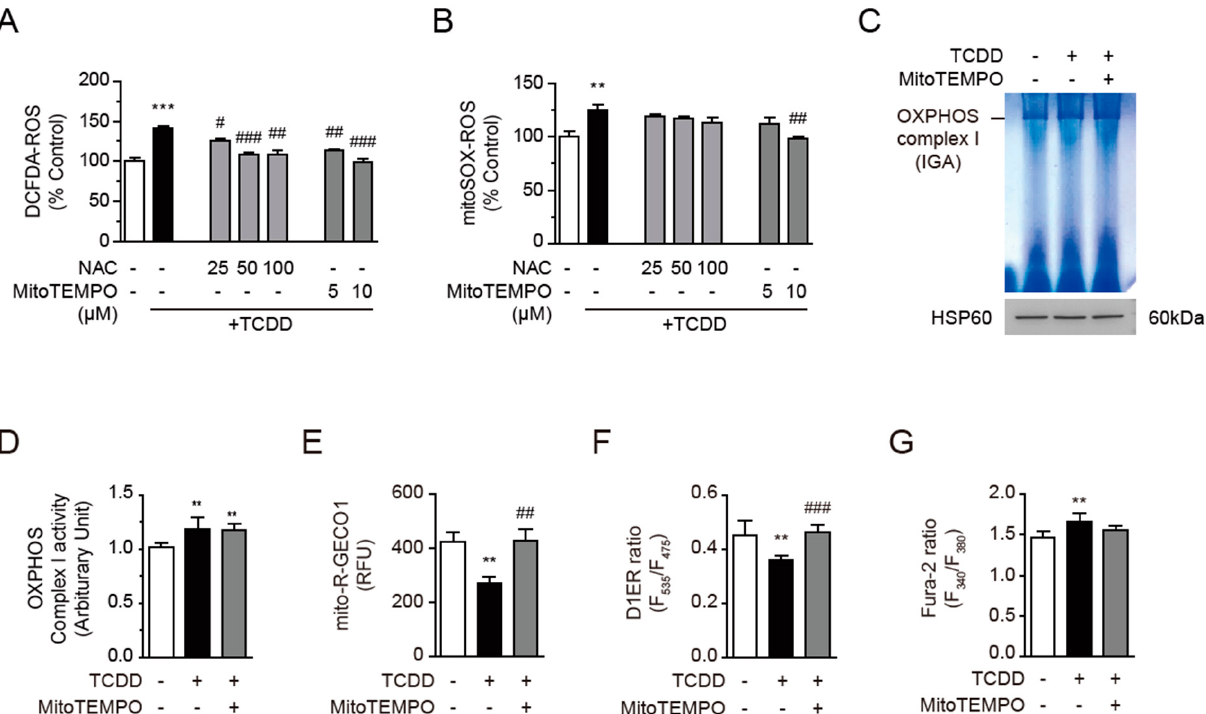
Figure 7. MitoTEMPO reversed the reductions in calcium in mitochondria and ER. ( A , B ) N- acetylcysteine (NAC) or MitoTEMPO was co-treated with TCDD (100 pM) in C2C12 cells for 24 h. Cytosolic or mitochondrial ROS were observed with a fluorometer using DCFDA (1 μ M, ( A )) or mitoSOX (5 μ M, ( B )), respectively. ( C – G ) C2C12 cells were incubated with TCDD (100 pM) in the presence or absence of MitoTEMPO (10 μ M) for 48 h. ( C ) In-gel activity (IGA) assay of OXPHOS complex Ⅰ . Isolated mitochondria from the cells were applied to blue native acrylamide gel electrophoresis, followed by an IGA assay for the OXPHOS complex Ⅰ, as described in the Materials and Methods. ( D ) The HSP60 antibody in the mitochondria used in the IGA assay was analyzed via Western blot and the ratio of band intensity levels of the OXPHOS complex Ⅰ to HSP60 is presented. ( E ) Mitochondrial calcium. Mito-R-GECO1-transfected cells were analyzed via confocal microscope after TCDD treatment and the fluorescent intensities are presented. ( F ) ER calcium. Calcium in the ER was measured using a fluorometer in D1ER-transfected cells. ( G ) Cytosolic calcium. C2C12 cells were loaded with Fura-2 AM (2 μ M, 20 min) and changes in cytosolic calcium were monitored using a fluorometer. Data are represented as means ± SEM ( n ≥ 4). ** p < 0.01, *** p < 0.001 vs. DMSO- treated cells; # p < 0.05, ## p < 0.01, ### p < 0.001 vs. TCDD-treated cells.